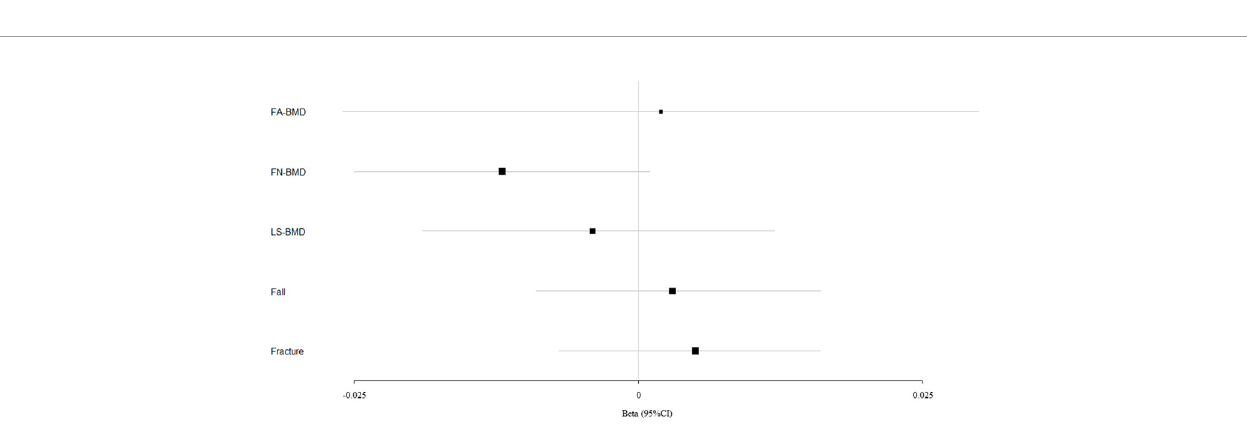
FIGURE 1 | Mendelian randomization estimates for the associations between SBP and outcomes. FA-BMD, forearm BMD; FN-BMD, femoral neck BMD; LS-BMD, lumbar spine BMD; CI, con fi dence interval.